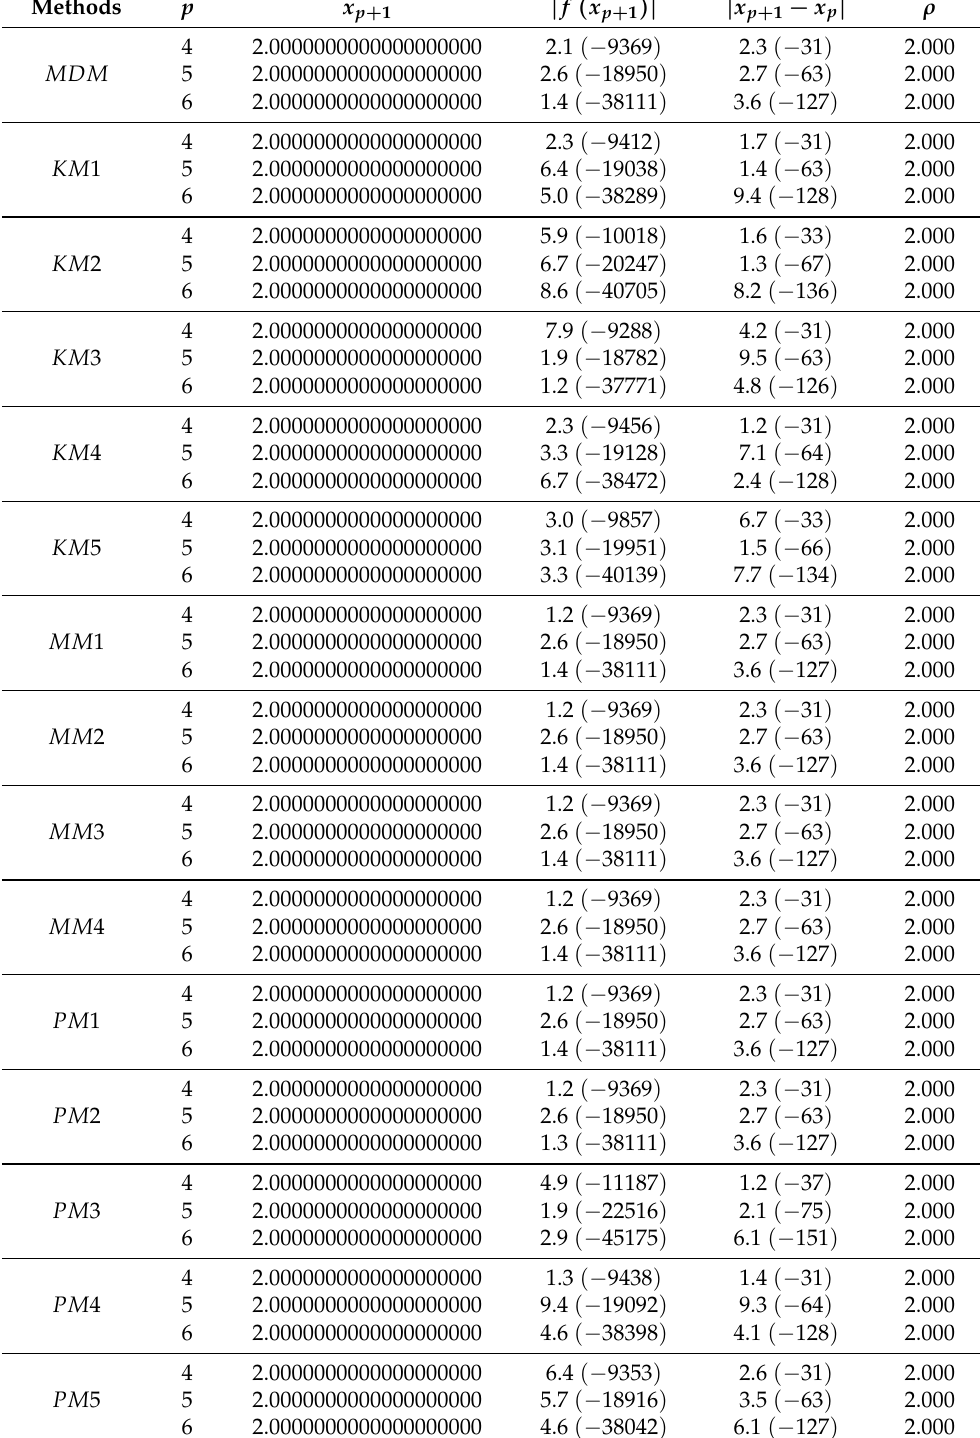
Table 6. Comparison of different iterative methods of Example